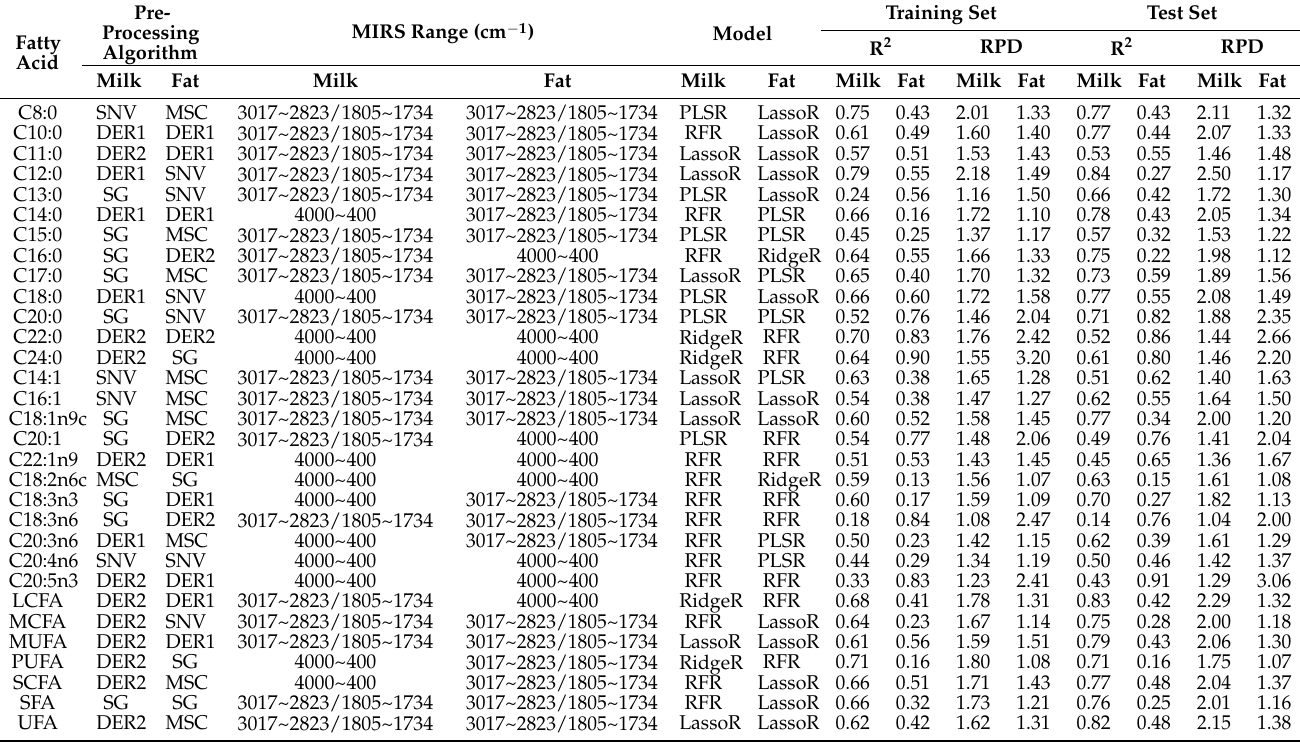
Table 3. Best prediction accuracy of different prediction models for each fatty acid expressed as g/100 g of fat and g/100 g of milk, using training and test